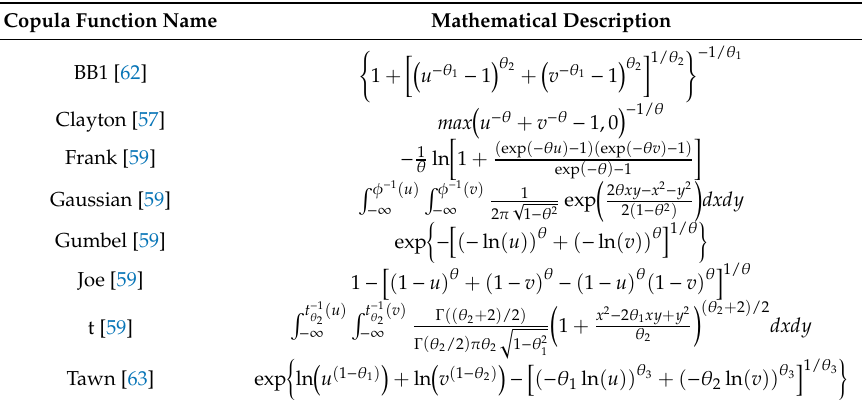
Table 1. Copula families and their closed-form mathematical